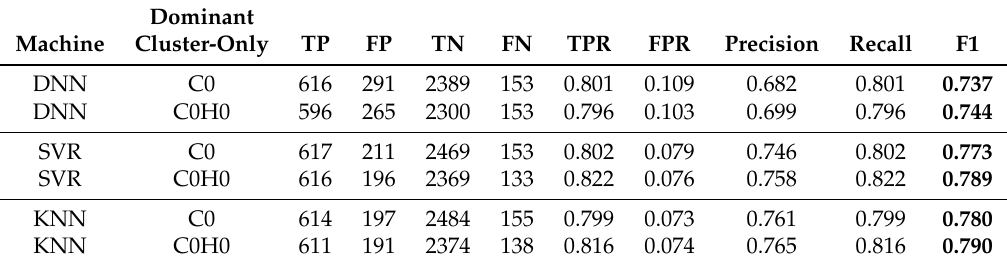
Table 12. Dominant Cluster Performance Evaluation of Various Machines and Types for Timesteps-128 and